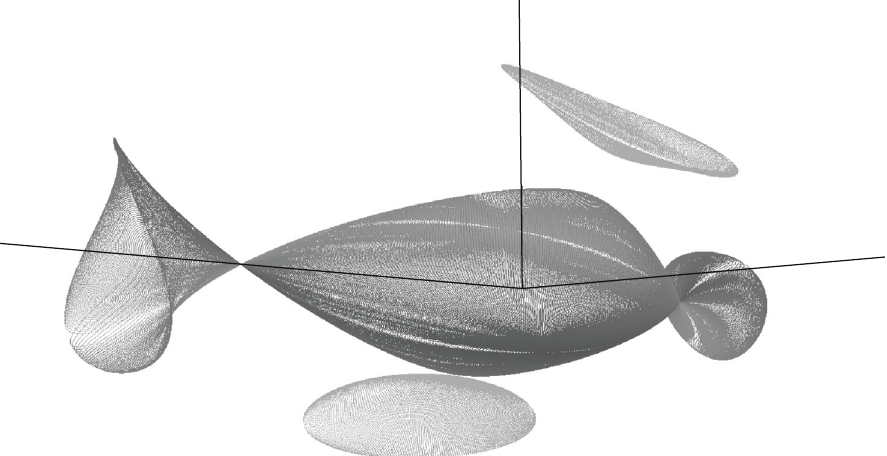
Figure 14: The wave front at t = 13 : 0 in the Type D metric. A new blue sky bifurcation has occurred with new sections of the null wave front appearing separated from the main wave front. We see cusp ridges on both ends of the wave front that are advancing from the spear in Figure